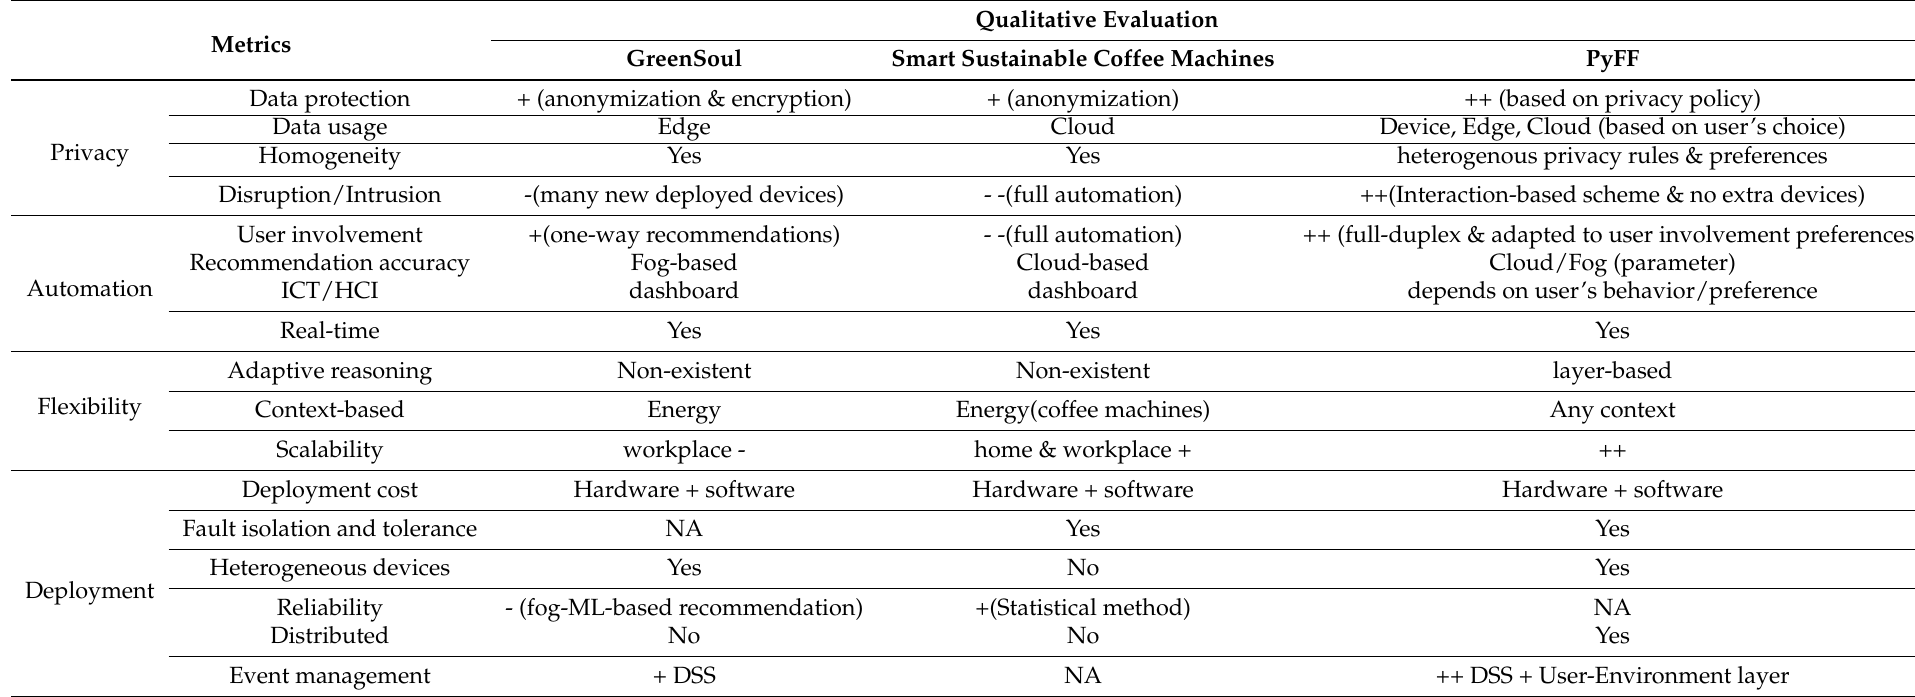
Table 1. PyFF qualitative